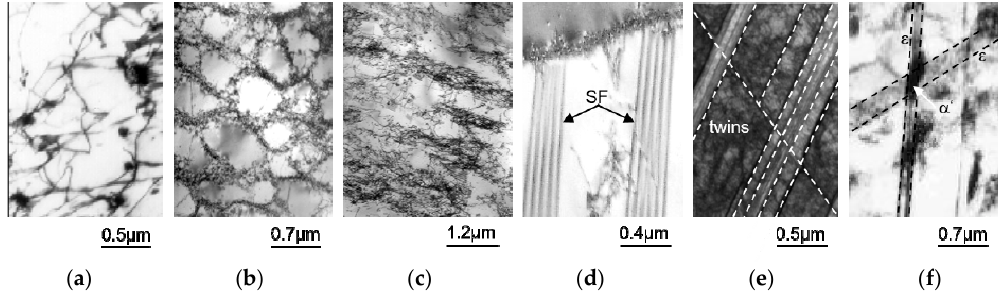
Figure 1. TEM micrographs with deformation and transformation microstructures of cyclically loaded metastable austenitic stainless steels: ( a ) typical dislocation density of the initial state after solution annealing, AISI 348 [58]; ( b ) cell dislocation structure (wavy slip character) at N f in AISI 348 fatigued with σ a = 280 MPa, R = − 1 at AT with f = 5 Hz [58]; ( c ) dislocation accumulation in one direction (planar slip character) at N f in AISI 348 fatigued with σ a = 260 MPa, R = − 1 at AT with f = 5 Hz [58]; ( d ) stacking faults (SF) at N f in AISI 304 fatigued with ε a,t = 0.325%, R = -1 at AT with f = 5 Hz [58]; ( e ) twins in AISI 347 fatigued with σ a = 160 MPa, R = − 1 at T = 300 °C with f = 980 Hz at N = 5 × 10 8 , ( f ) ε - and α d -martensite at N f in AISI 321 fatigued with σ a = 330 MPa, R = − 1 at AT with f = 5 Hz